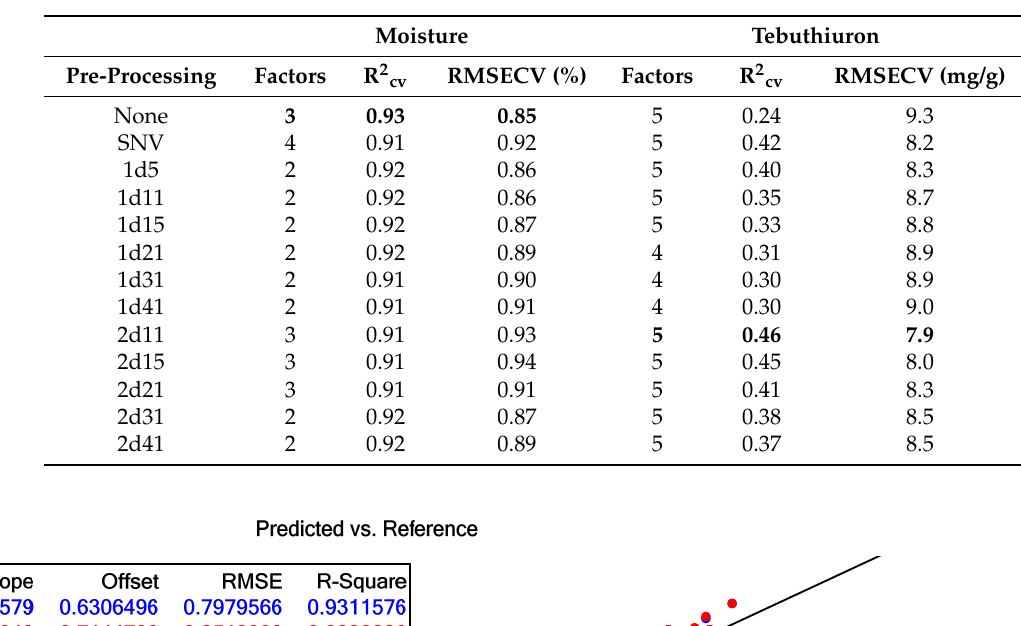
Table 7. Optimum pre-processing methods for the prediction of moisture and tebuthiuron content in Regain granules using the benchtop Antaris NIR instrument. The best-performing model for each analyte is highlighted in bold.